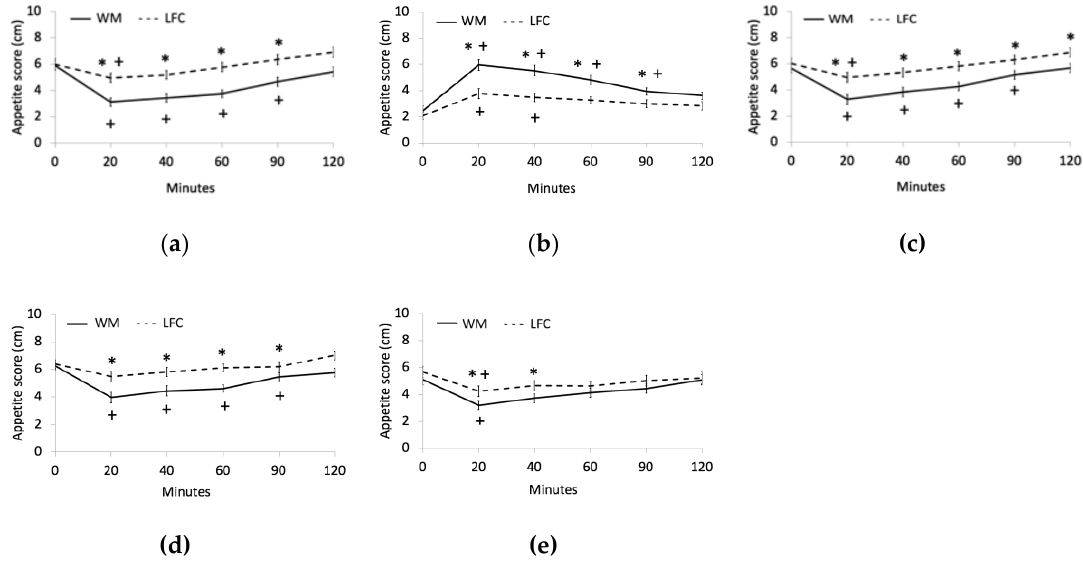
Figure 1. Effects of watermelon (WM) and low-fat cookies (LFC) on ( a ) hunger, ( b ) fullness, ( c ) desire to eat, ( d ) prospective food consumption, and ( e ) thirst. *: different between WM and LFC; +: different from baseline. VAS: visual analogue scale.